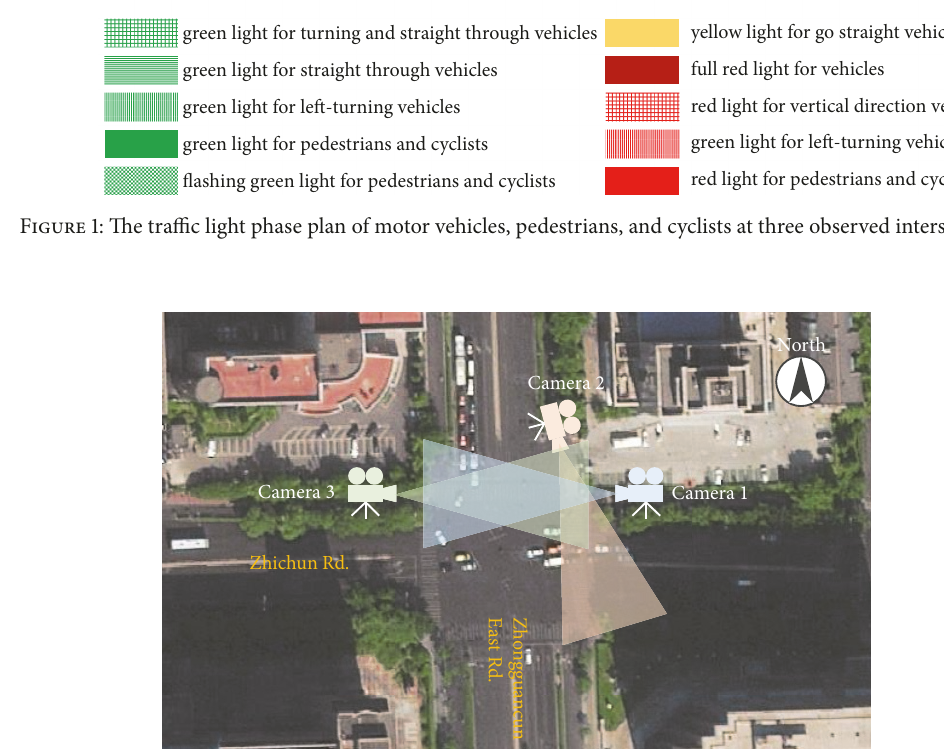
positioned on the opposite side of crosswalk to shoot the same road user group. Camera 2 was placed on the vertical direction with Camera 1 and Camera 3 as